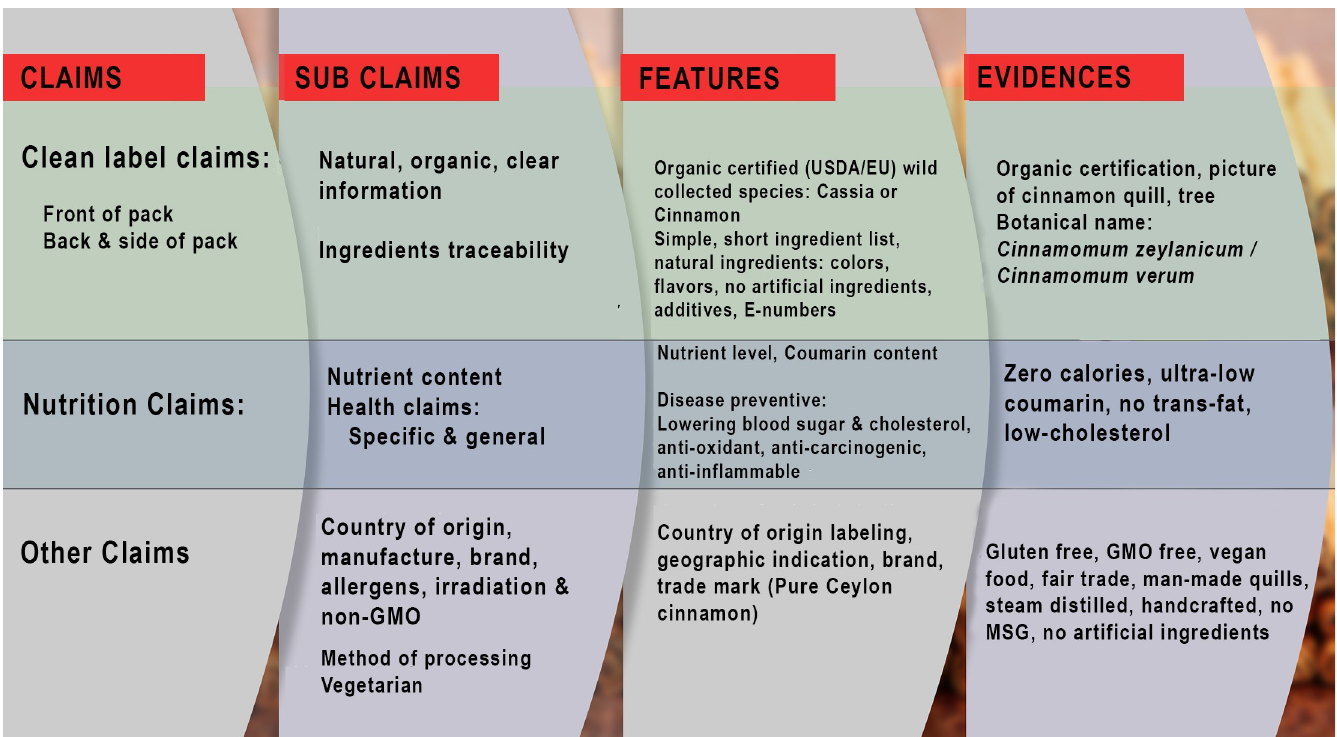
Fig 4. Blueprint of the clean labels. An overview of the types of claims displayed on the labels of cinnamon value added retail packs. Organic, natural, clear information, list of ingredients and traceability are sub claims of clean label claims. Nutrition claims mainly appeared as nutrient content, specific and general health claims. Country of origin, manufacturer, brand, allergens, irradiation free, non GMO, method of processing, vegetarian were other common claims. Symbols of standards and certifications appear as evidence for the consumers.